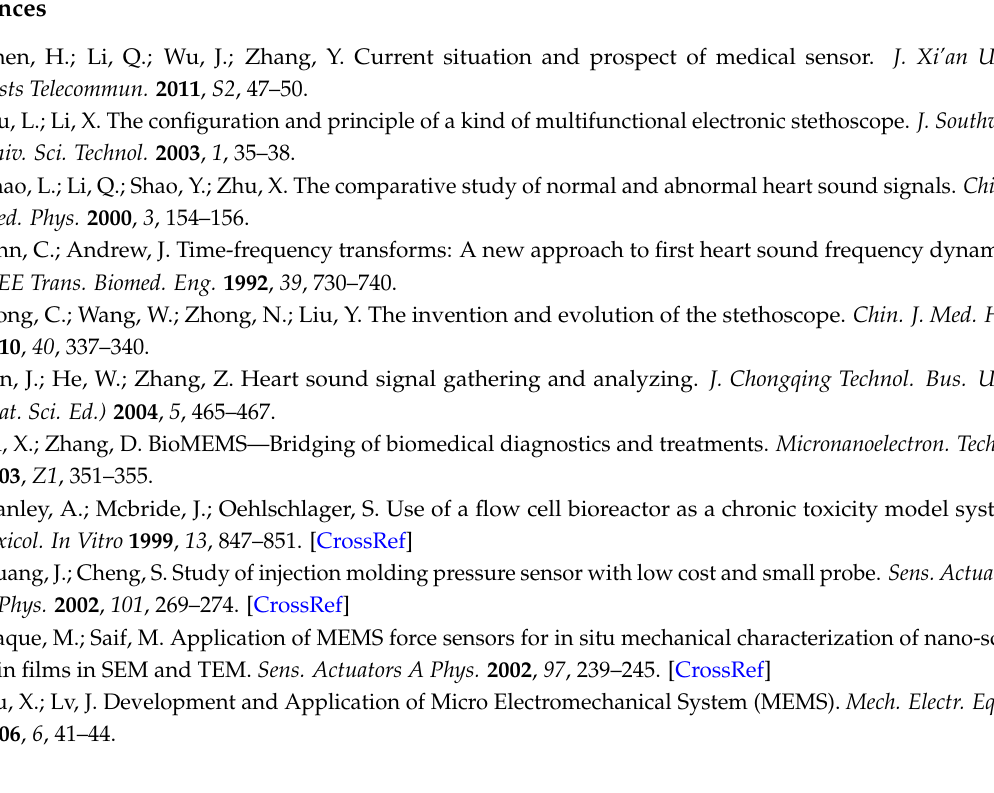
Figure 16. SNR test of the 3200-type electronic stethoscope. ( a ) Heart sound signals; and ( b ) output without the heart sound signals.